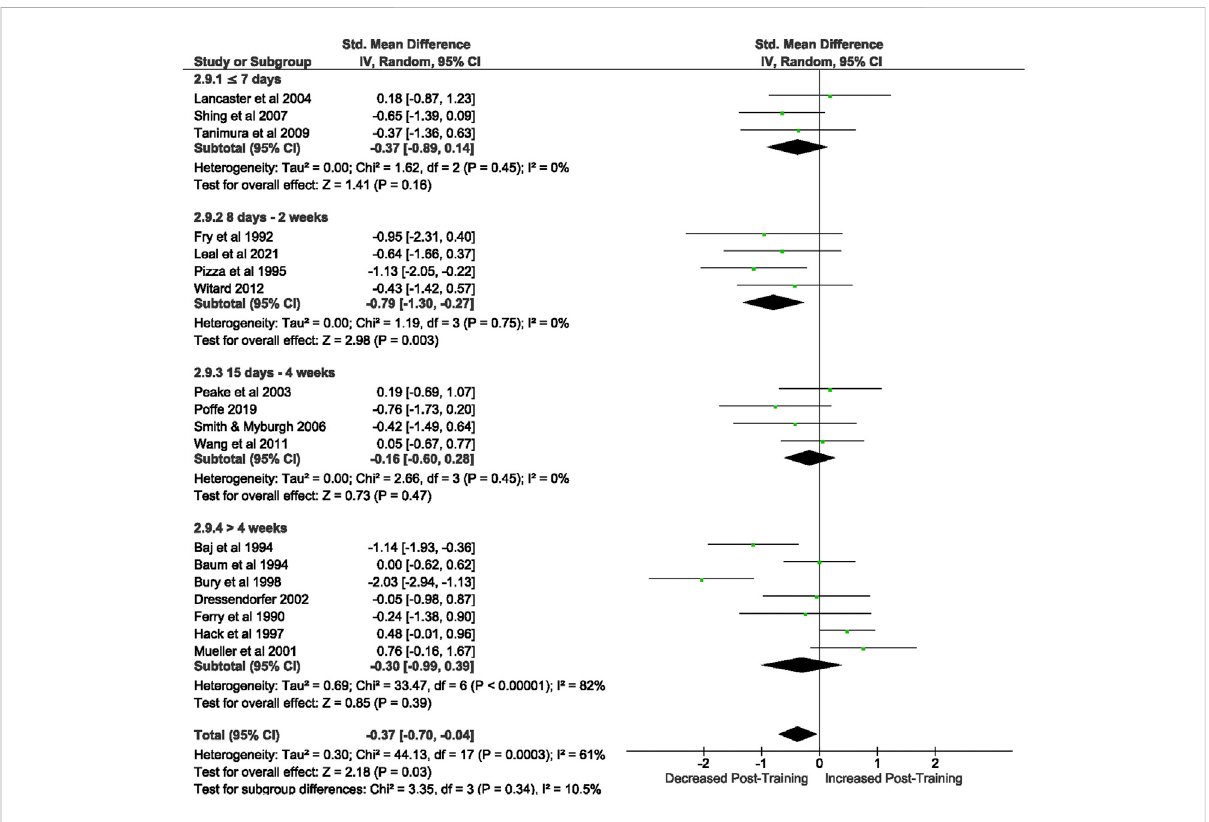
FIGURE 5 Effect of intensi fi ed training on resting CD8+ T cell counts, measured by FACS or Automated cell counter. Subgroup analysis is based on the duration of intensi fi ed training period; ≤ 7 days, 8 days — 2 weeks, 15 day — 4 weeks and > 4 weeks. All studies used human participants. CI Con fi dence